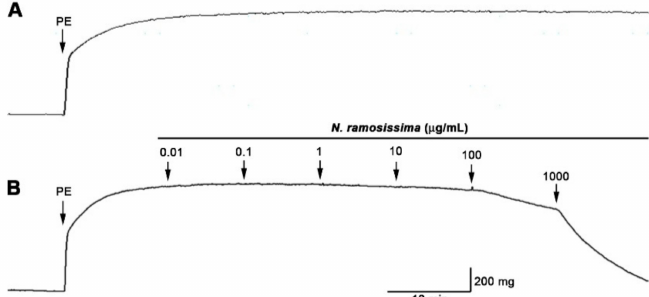
Figure 6. Original record of the relaxation e ff ects of N. ramosissima in intact rat aorta. Rat aorta was pre-contracted with 10 − 6 M phenylephrine (PE) for 10 min, and then, cumulative concentrations of N. ramosissima (0.01 to 1000 g / mL) were added in organ bath at 7 min intervals ( B ) to compare with the control ( A ).